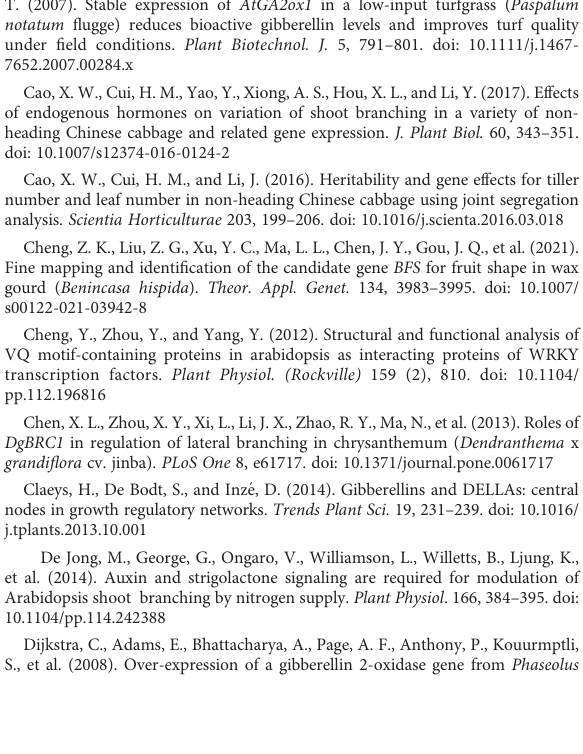
SUPPLEMENTARY FIGURE 1 The full-length of gene BraA07g041560.3C . SUPPLEMENTARY FIGURE 2 The full-length of gene BraA07g041570.3C . SUPPLEMENTARY FIGURE 3 The promoter sequence of BraA07g041560.3C . SUPPLEMENTARY FIGURE 4 The promoter sequence of BraA07g041570.3C . SUPPLEMENTARY TABLE 1 KASP primer sequence used in this study. SUPPLEMENTARY TABLE 2 SNP site information. SUPPLEMENTARY TABLE 3 The components of the KASP reaction mixture. SUPPLEMENTARY TABLE 4 The 178 genes identi fi ed in the candidate region based on the gene information in the Brassica